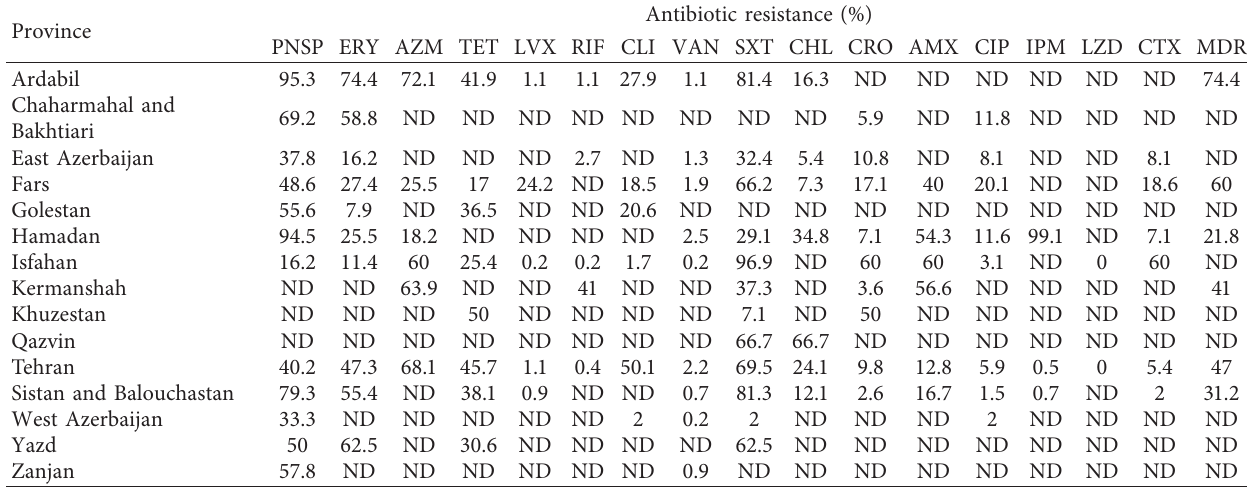
Table 2: S. pneumoniae antibiotic resistance profiles in different provinces of